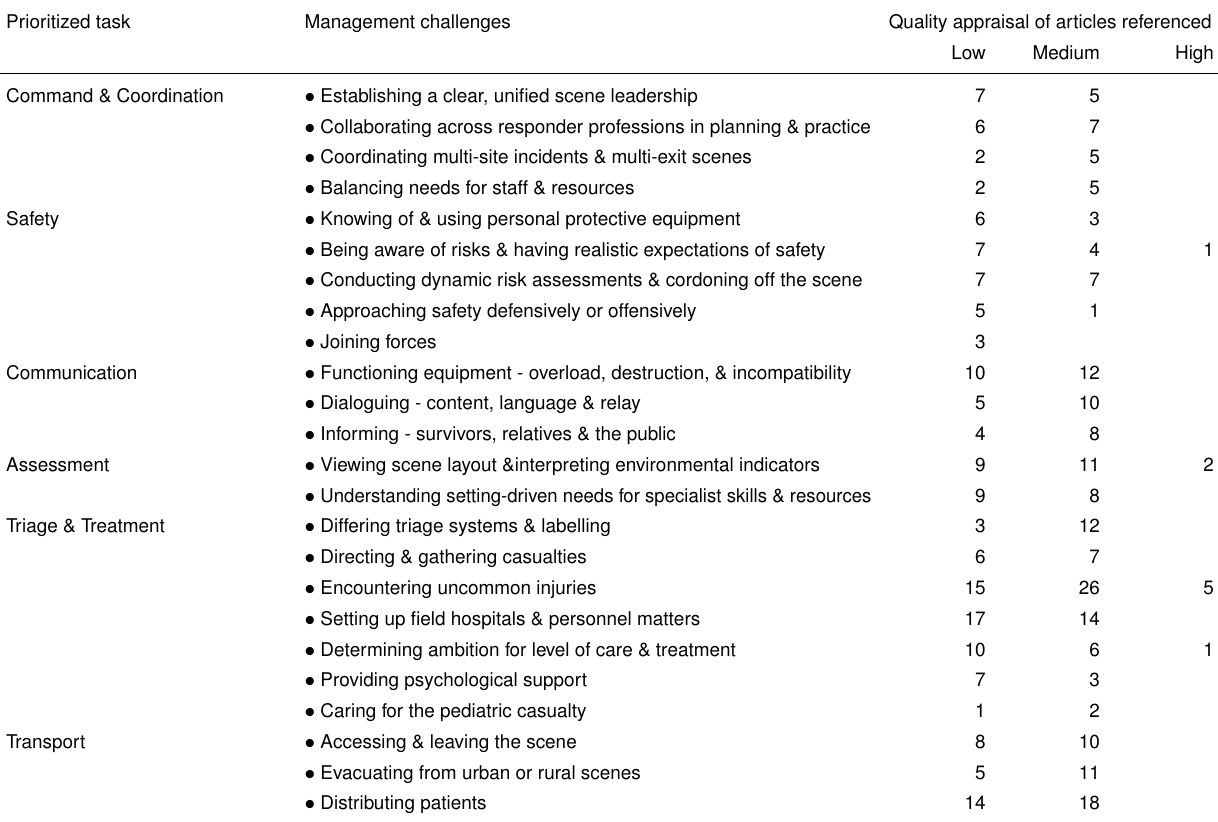
Table 2. Summary of defined challenges and corresponding scientific quality of